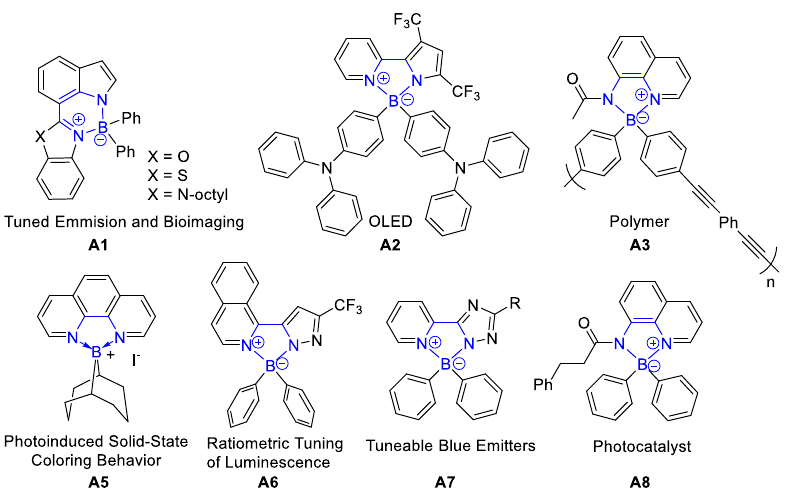
Figure 1. Application of tetracoordinate organoboron complexes in luminescent materials, organic light-emitting diode (OLED), functional polymer, and photocatalyst [30–36].